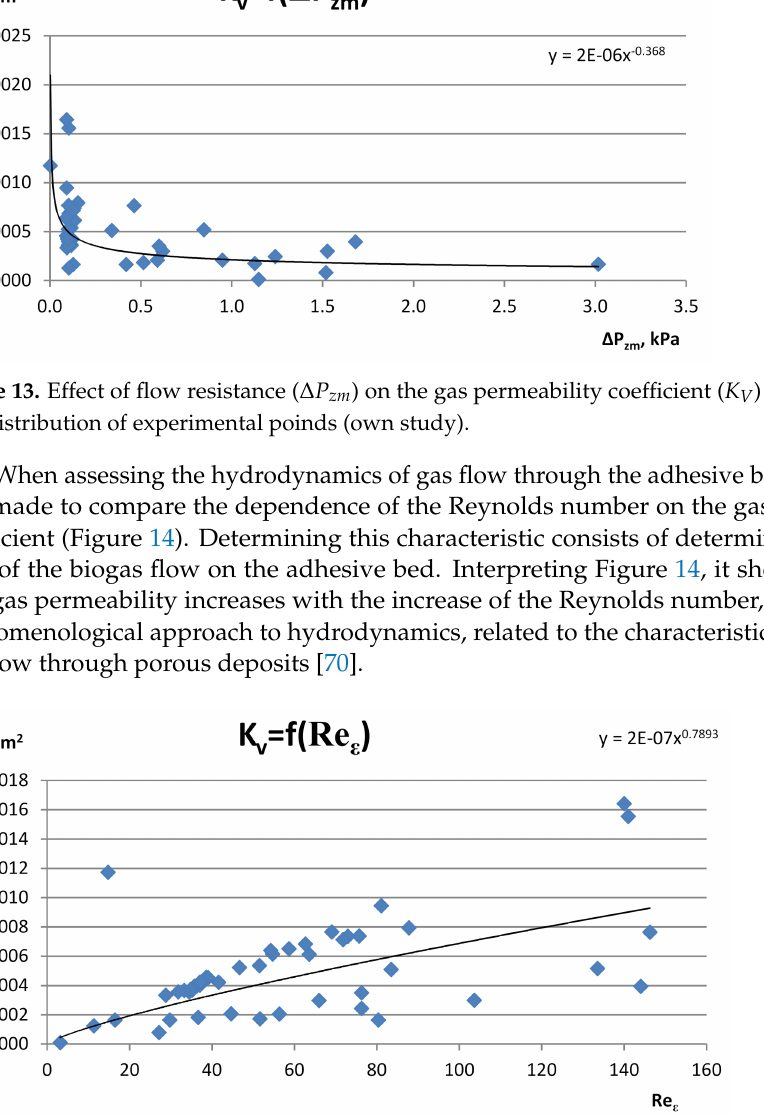
Figure 14. Influence of Reynolds number ( Re ε ) on the gas permeability coefficient ( K V ) of the adhesive bed-distribution of experimental points (own